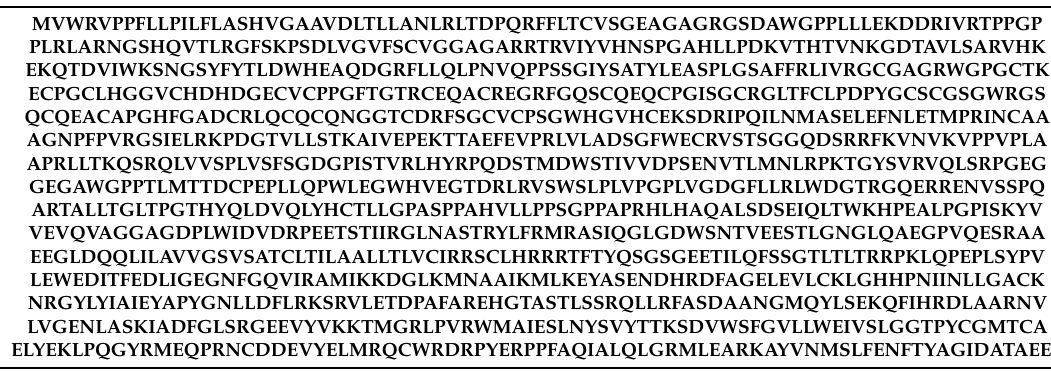
Table 4. Primary amino acid sequence used to search for templates in order to build models for